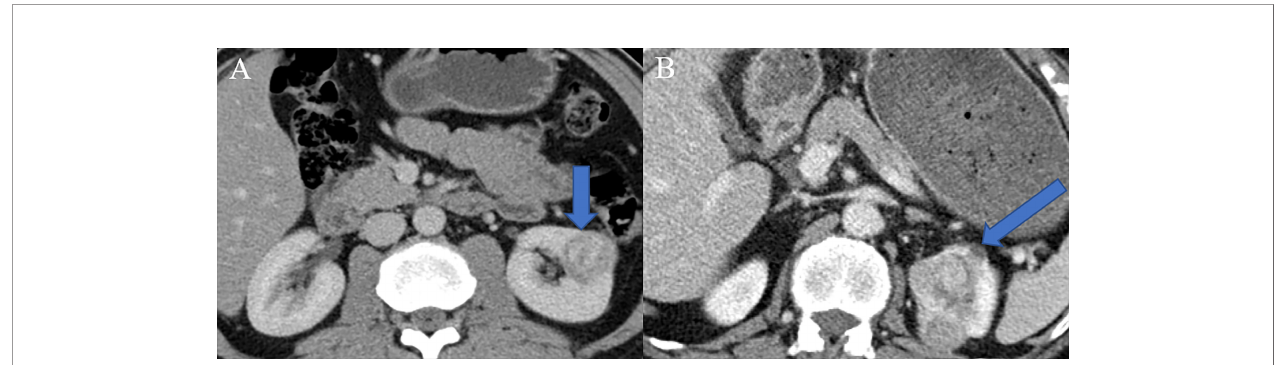
FIGURE 2 | Two representative nephrographic phase CT images. (A) A patient with low-grade CCRCC, there was no speci fi c radiological features in the presented CT image. (B) A patient with high-grade CCRCC, tumor necrosis, angiogenesis, and perinephric invasion phenomena were observed in the presented CT